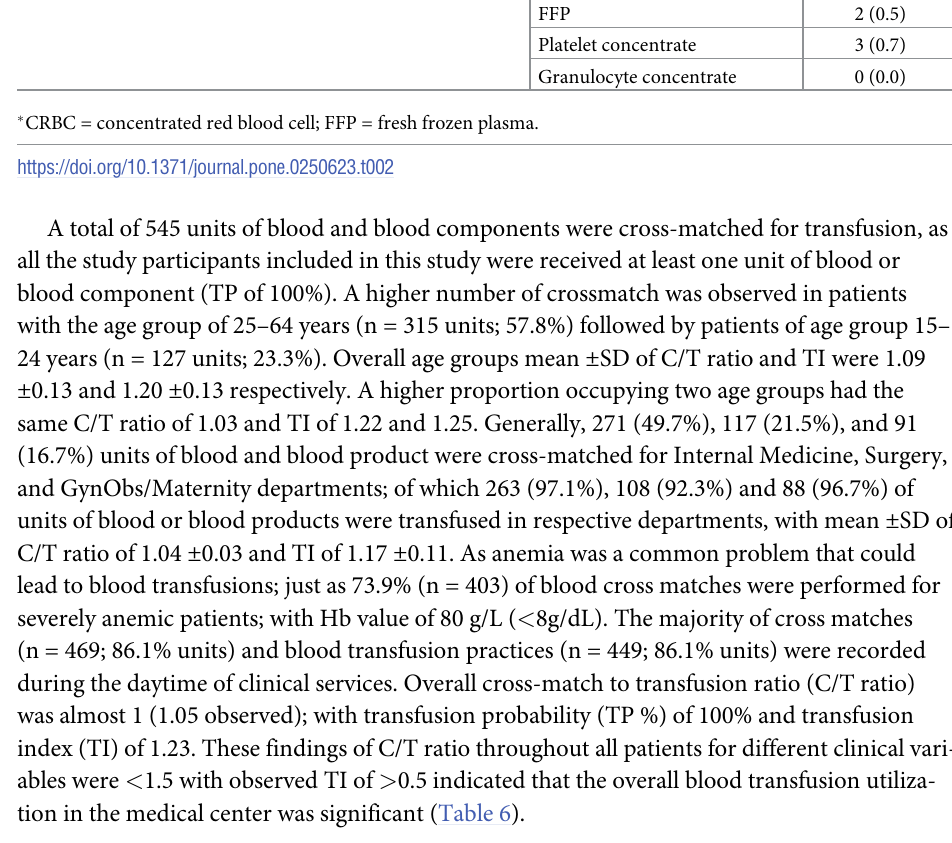
Table 2. Indicators of blood transfusion practice at JMC, southwest Ethiopia, February 1 to June 30, 2018 (n = 425). Variables n (%) Number of units indicated/prescribed for transfusion 1 unit 173 (40.7) 2 units 143 (33.6) 3 units 88 (20.7) 4 units 19 (4.5) 5 units 2 (0.5) Number of units issued for transfusion 1 unit 328 (77.2) 2 units 79 (18.6) 3 units 15 (3.5) 4 units 3 (0.7) 5 units 0 (0.0) Components indicated/prescribed for transfusion Whole blood 302 (71.1) � CRBC 113 (26.6) � FFP 3 (0.7) Platelet concentrate 6 (1.4) Granulocyte concentrate 1 (0.2) Components administered for transfusion Whole blood 412 (96.9) CRBC 8 (1.9) FFP 2 (0.5) Platelet concentrate 3 (0.7) Granulocyte concentrate 0 (0.0) � CRBC = concentrated red blood cell; FFP = fresh frozen